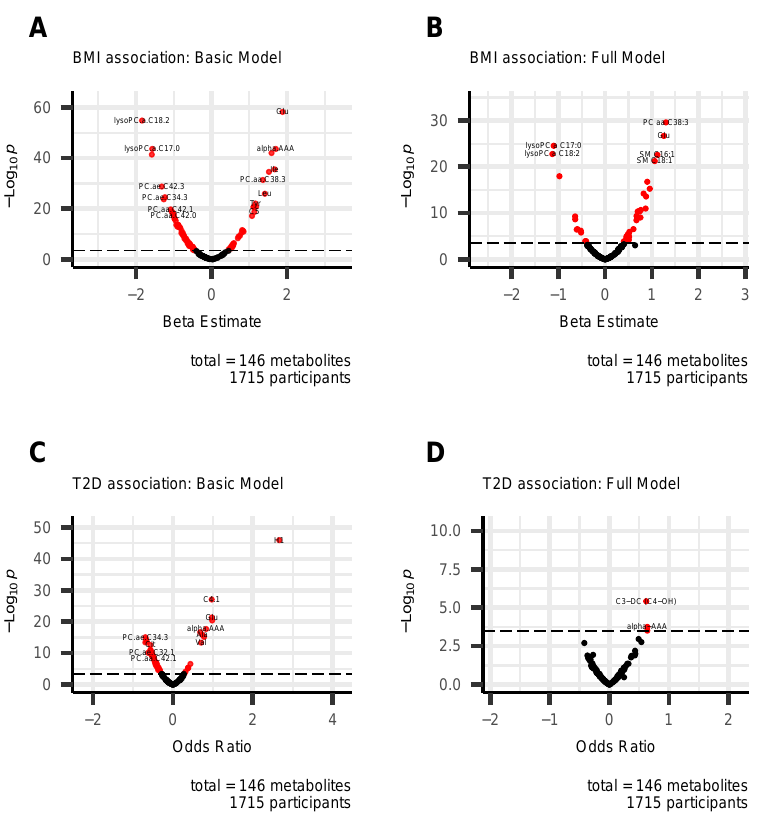
Figure 2. Volcano plots show the association of metabolites with BMI and T2D in the basic model ( A , C ) and the full model ( B , D ). Bonferroni correction p -value cut-off is 0.05/146 = 0.00034 was considered. Each dot represents a metabolite, and they are displayed based on the beta estimate or odds ratio ( x -axis) and the negative logarithm (base 10) of the p -value ( y -axis). The covariates for the basic model are age, sex, and (BMI); the covariates for the full model are age, sex, (BMI), smoking status, physical activities, HDL-C, blood pressure, triglycerides, and fasting